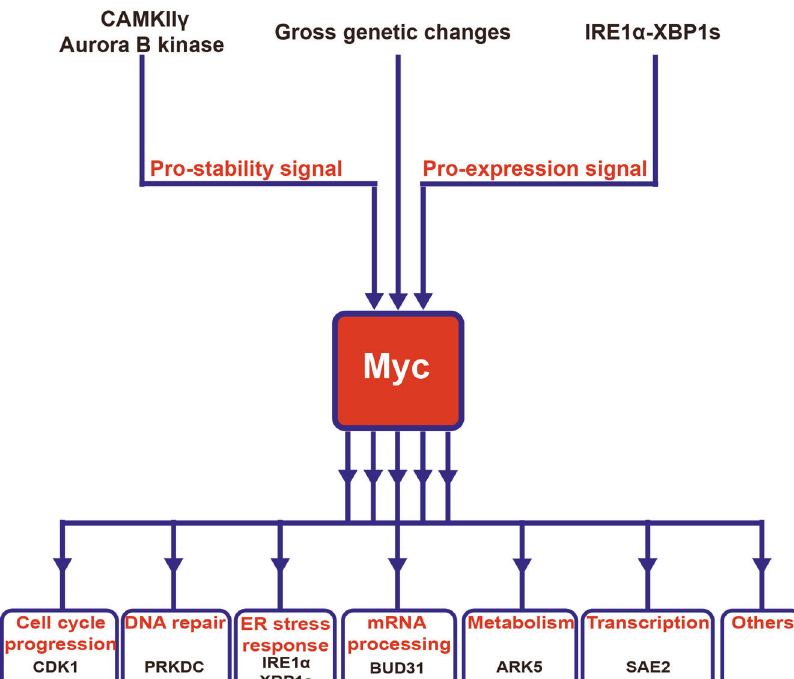
Fig. 4 Rewired signal pathways by deregulated Myc in cancer and its related components available for synthetic lethality. Input signals, including pro-stability signals from CAMKII γ or Aurora B kinase, pro-expression signals from IRE1 α – XBP1s pathway, and gross genetic changes of Myc, lead to the deregulation of Myc. Multiple pathways, including cell cycle progression, DNA repair, ER stress response, mRNA processing, metabolism, and transcription, were rewired by the output signal from oncogenic Myc to meet its oncogenic needs. Among these Myc- educated signal pathways, some related components indicated here have been veri fi ed as synthetic lethal partners of oncogenic